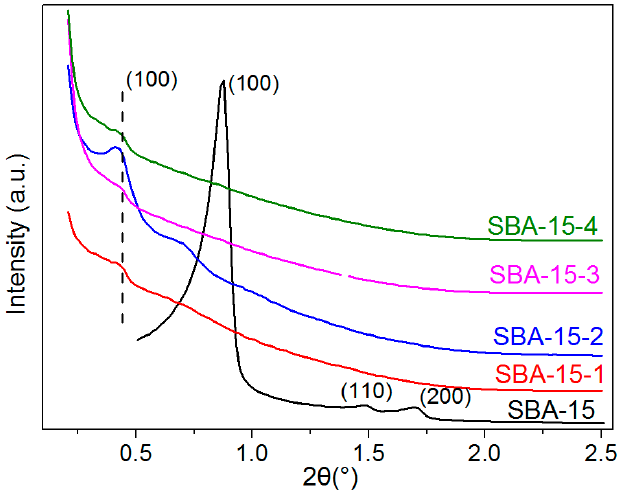
Figure 2. Powder X-ray diffraction (XRD) patterns of SBA-15 particles with different pore sizes.